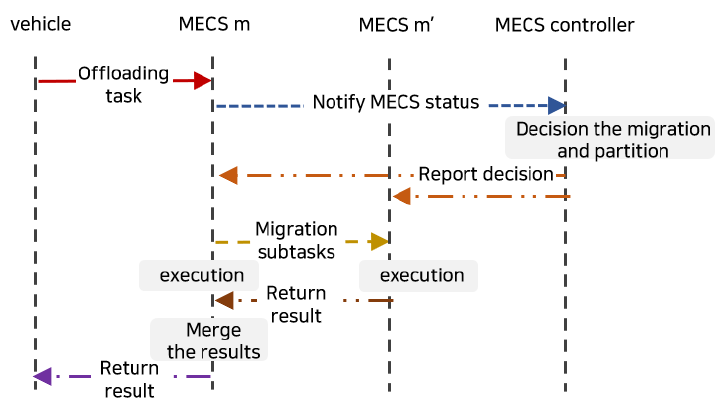
Figure 2. The operation of a MEC network.